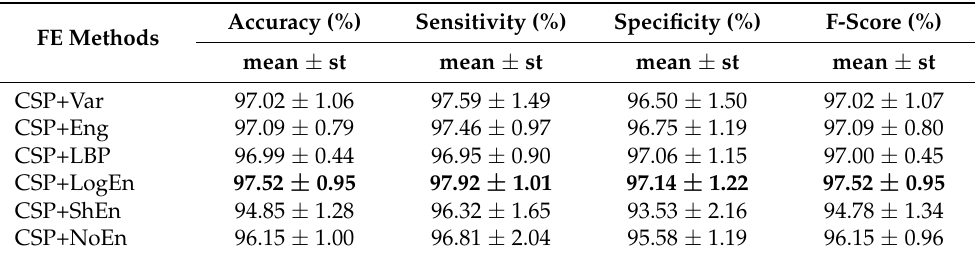
Table 12. Classification results of off–PD vs. on–PD using KNN